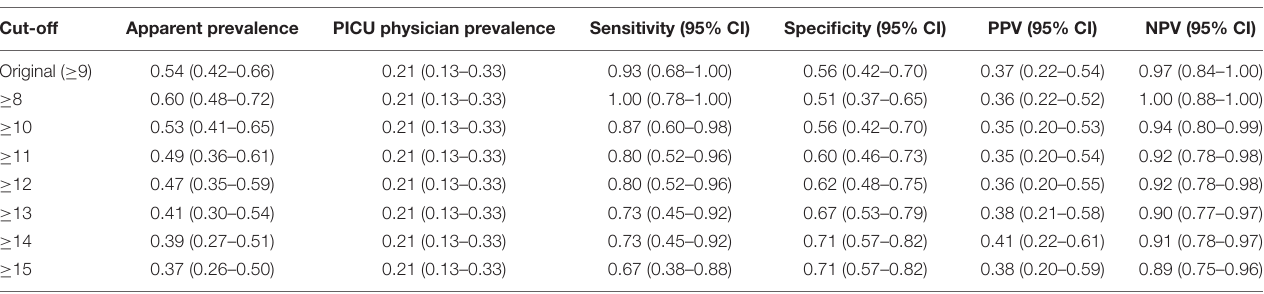
TABLE 3 | Sensitivity, specificity, PPV, and NPV according to different cut-off of the CAPD scale.